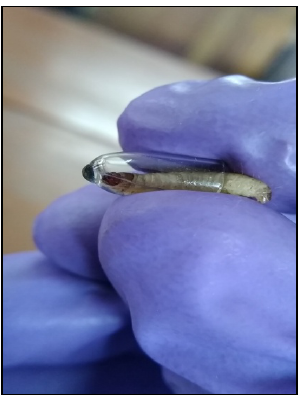
Figure 1. Force feeding of antibiotic (9 µl of 1 mg/mL) solution to larvae